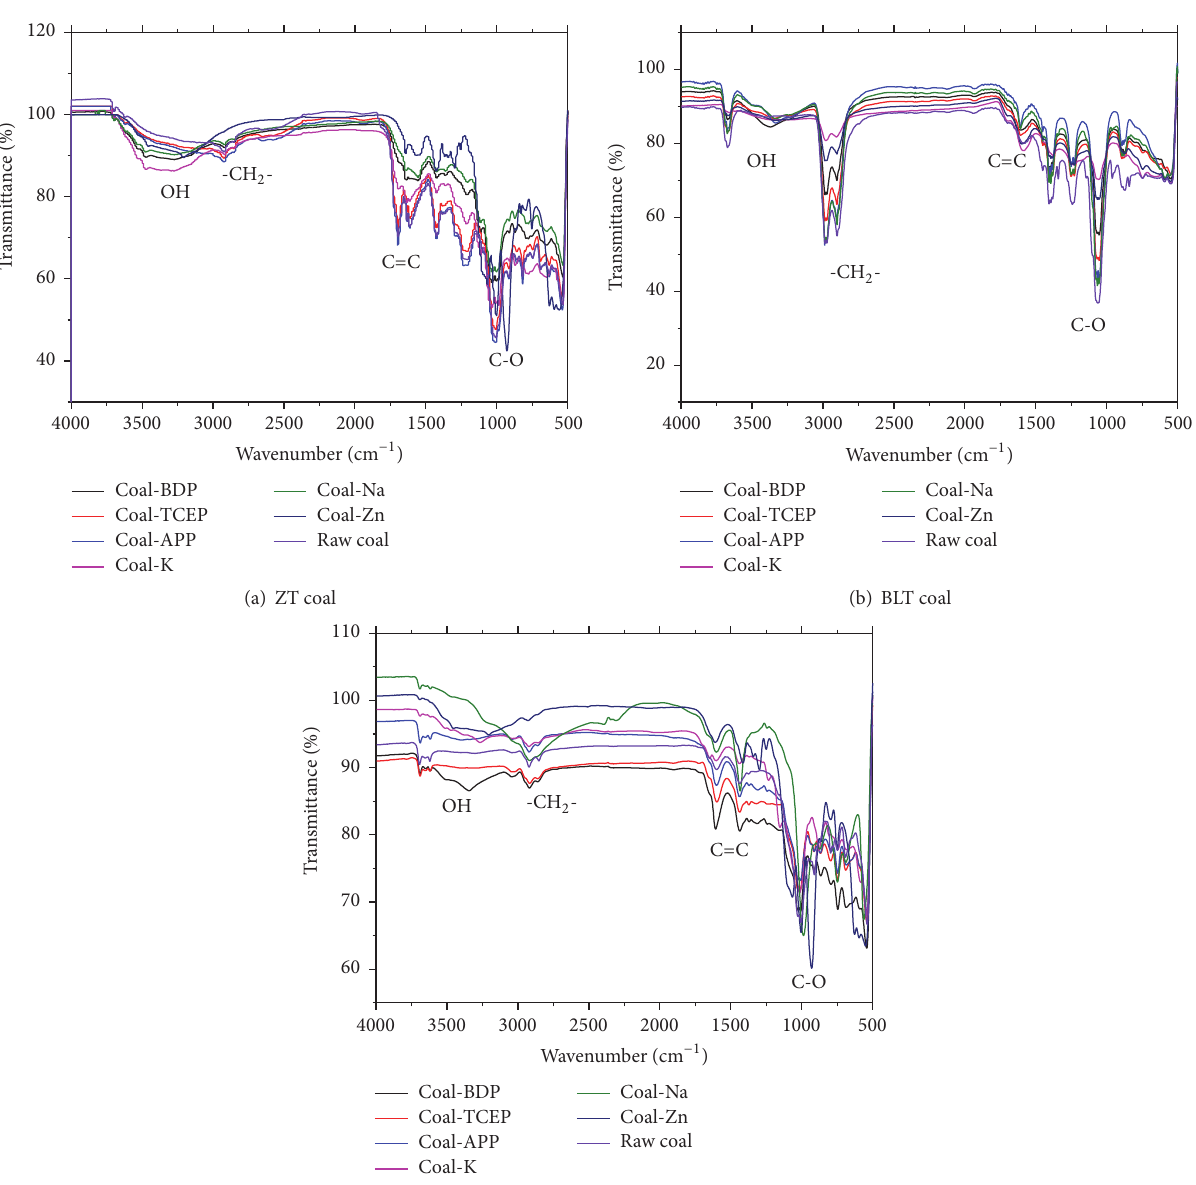
Figure 1: The experimental setup.